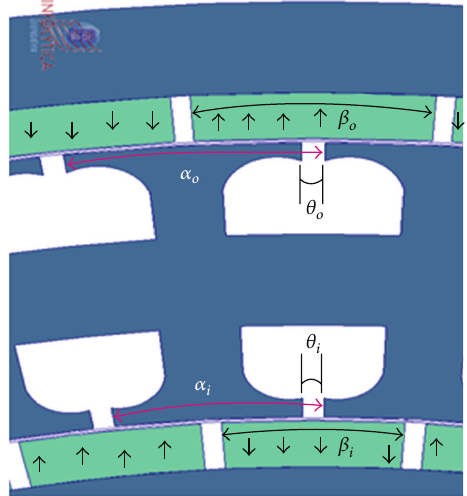
Figure 2: Section of DRFPMG FEA